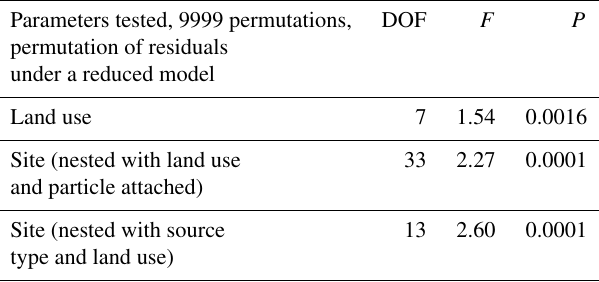
Table 2. Results of permutational multivariate analysis of variance (PERMANOVA). DOF represents degrees of